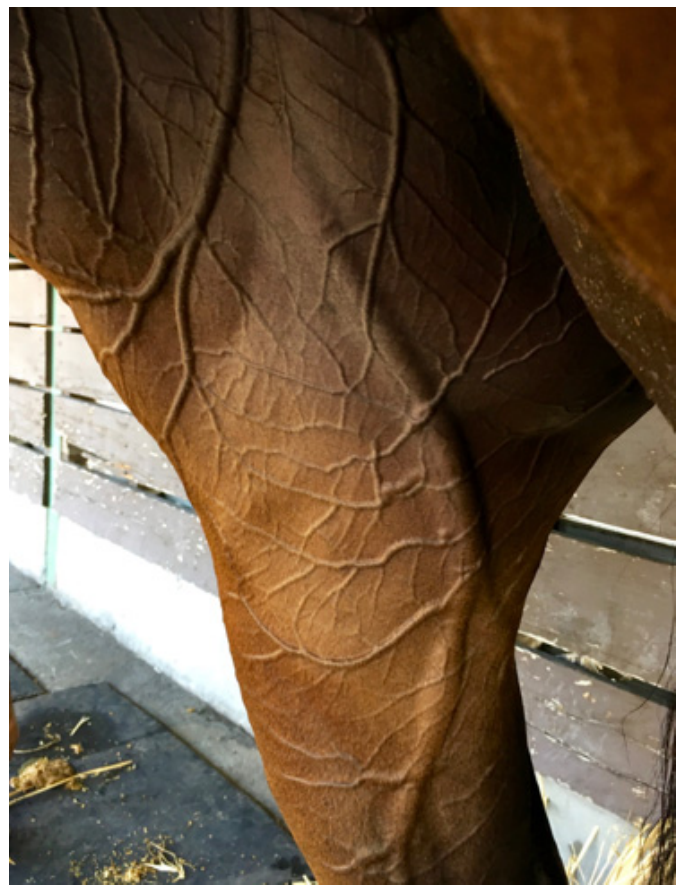
Figure 6. The medial aspect of the hindleg of a horse some 15 min after racing. Note the intricate pattern of small vessels and the large dilated saphenous vein minutes after racing [31]. For the track veterinarian, a knowledge of the physiology of the recovery period is of crucial importance because this is the time when horses are at greatest risk of EHI, and it is sometimes difficult to discern between physiological changes resulting from a very arduous run and those due to emergent EHI. Source—J Equine Vet Ed,